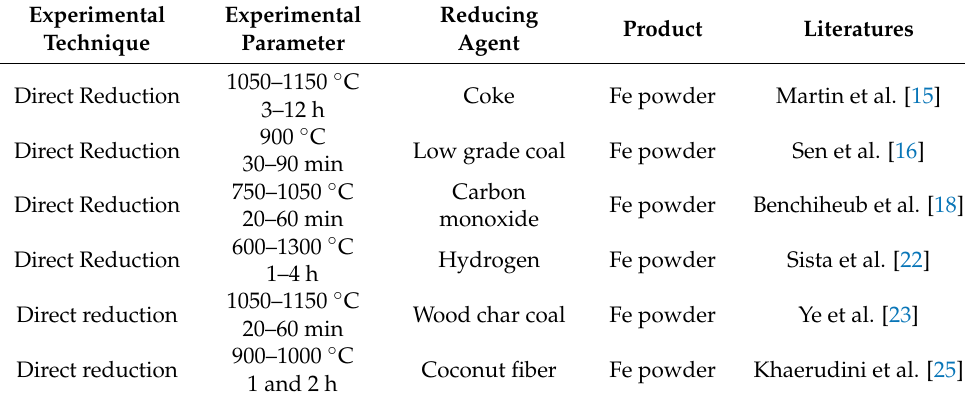
Table 1. Previous research work on reduction of mill